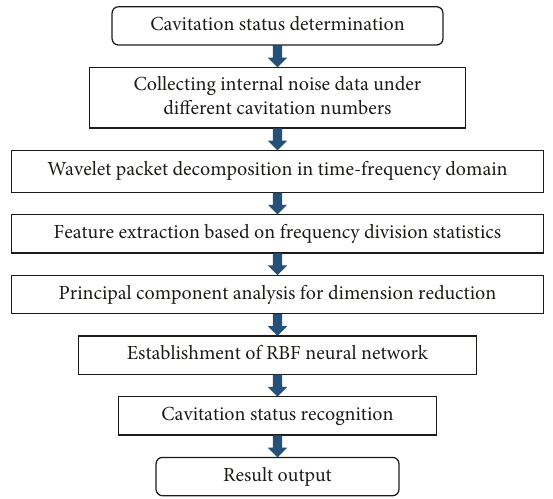
Figure 1: Flow chart of the cavitation detection